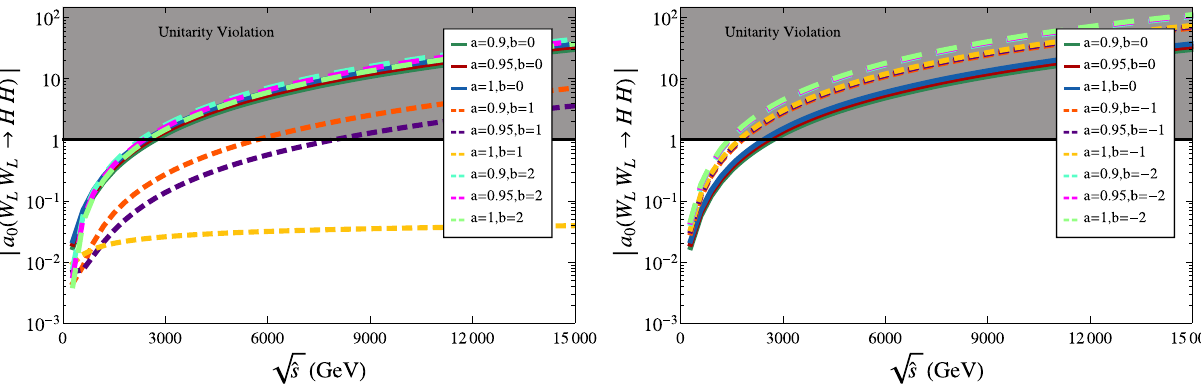
Fig. 9 Modulus of s -wave partial amplitudes, as a function of the CM energy, for the W L W L → H H subprocess in the EChL, for different values of the parameters a and b . The dashed yellow line corresponds